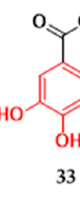
Figure 7. Phenolic acids with antibacterial activity isolated from plants in Brazil. Gallic acid ( 32 ) and protocatechuic acid ( 33 ) .